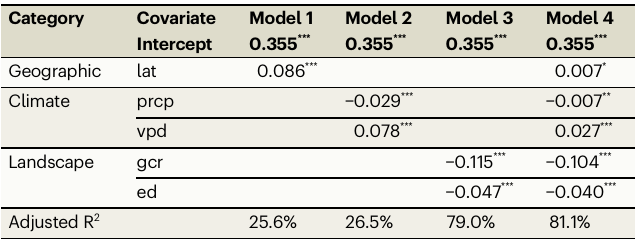
Table 2 | Summary of multiple linear regression models